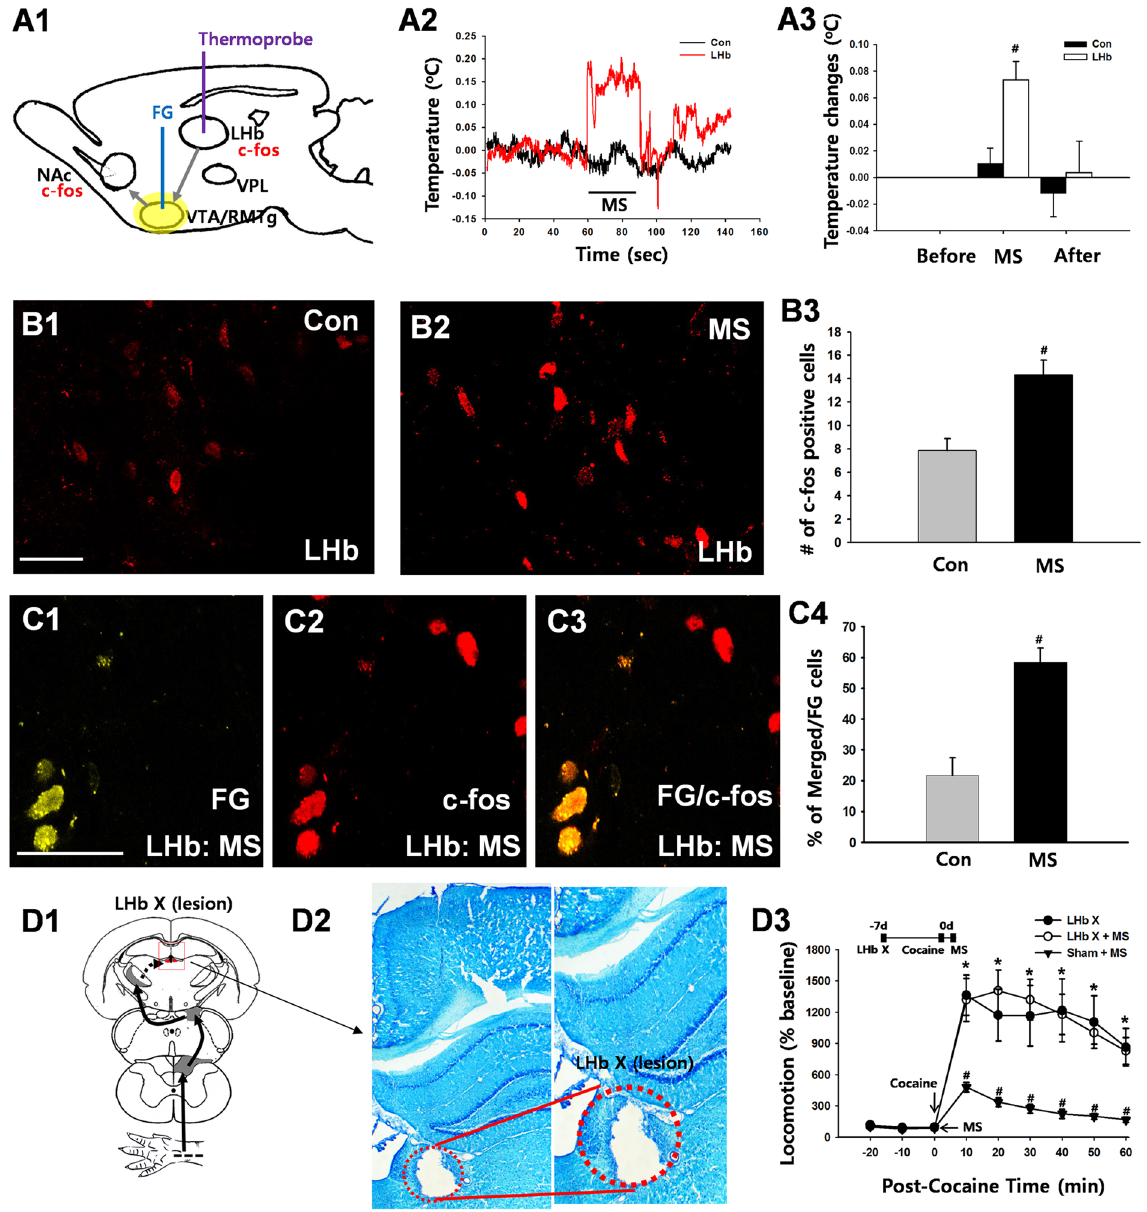
Figure 4. The role of VTA/RMTg projections to the lateral habenula (LHb) on ulnar inhibition of cocaine locomotion. ( A ) Ulnar MS increases LHb temperature (A1–3). ( B ) Activation of LHb neurons projecting to the VTA/RMTg regions following ulnar stimulation. The number of c-fos positive cells in the LHb increased by approximately 2-fold in ulnar MS rats (MS, B2-B3; n = 5) compared to rats in the control group (Con; B1; n = 5). ( C ) c-fos LHb positive cells (C2) were labeled retrogradely with fluorogold (FG; yellow; C1) injected into the VTA/RMTg regions (C1–3). The number of c-fos positive cells double-labeled with FG significantly increased in ulnar MS (n = 5), compared to control (Con; n = 5; C4). # p < 0.05 vs. Con. ( D ) Electrolytic lesions of LHb (LHb X; D1–2) prevented ulnar MS-induced inhibition of cocaine-induced locomotion (LHb X + MS; n = 5), compared to the control groups of LHb lesion only ( n = 5) and Sham + MS ( n = 5) (D3). # p < 0.05 vs. LHb X. * p < 0.05 vs. Sham +